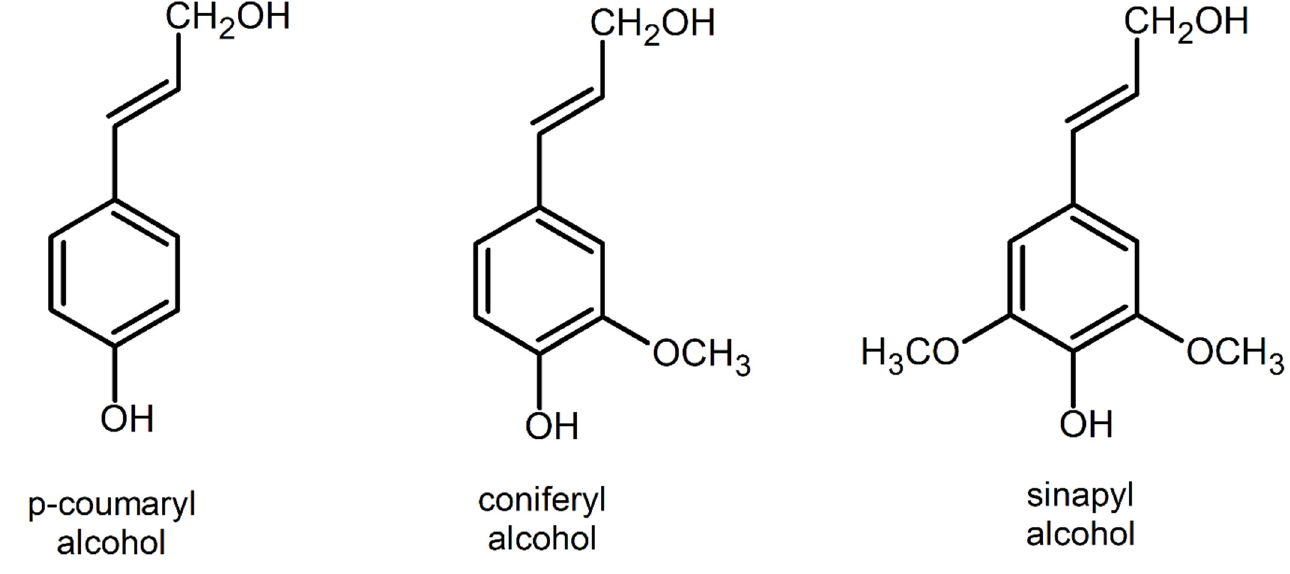
Figure 1. Monolignols-precursor molecules responsible for the intrinsic structure of lignin.